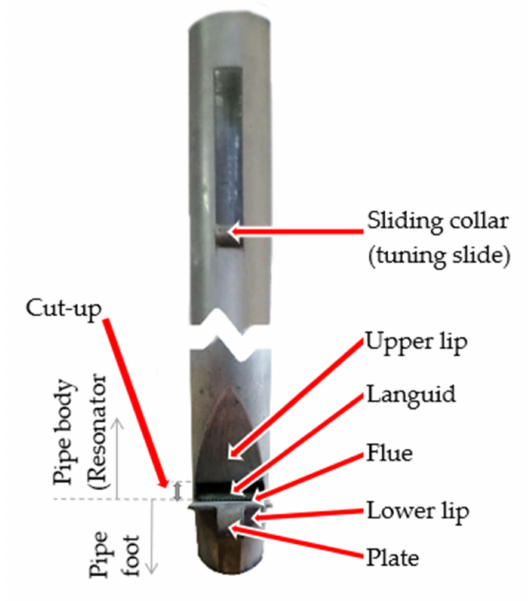
Figure 5. The structure of a flue (labial)